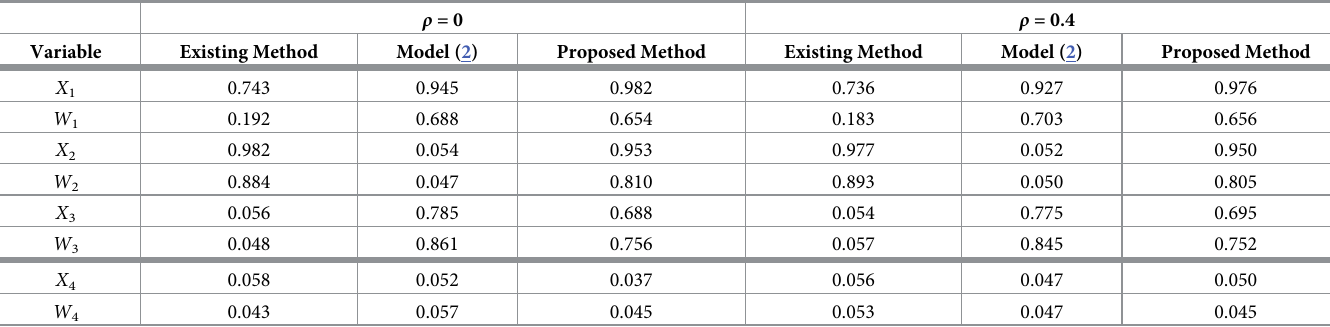
Table 5. Power and type I error comparison for cluster poisson